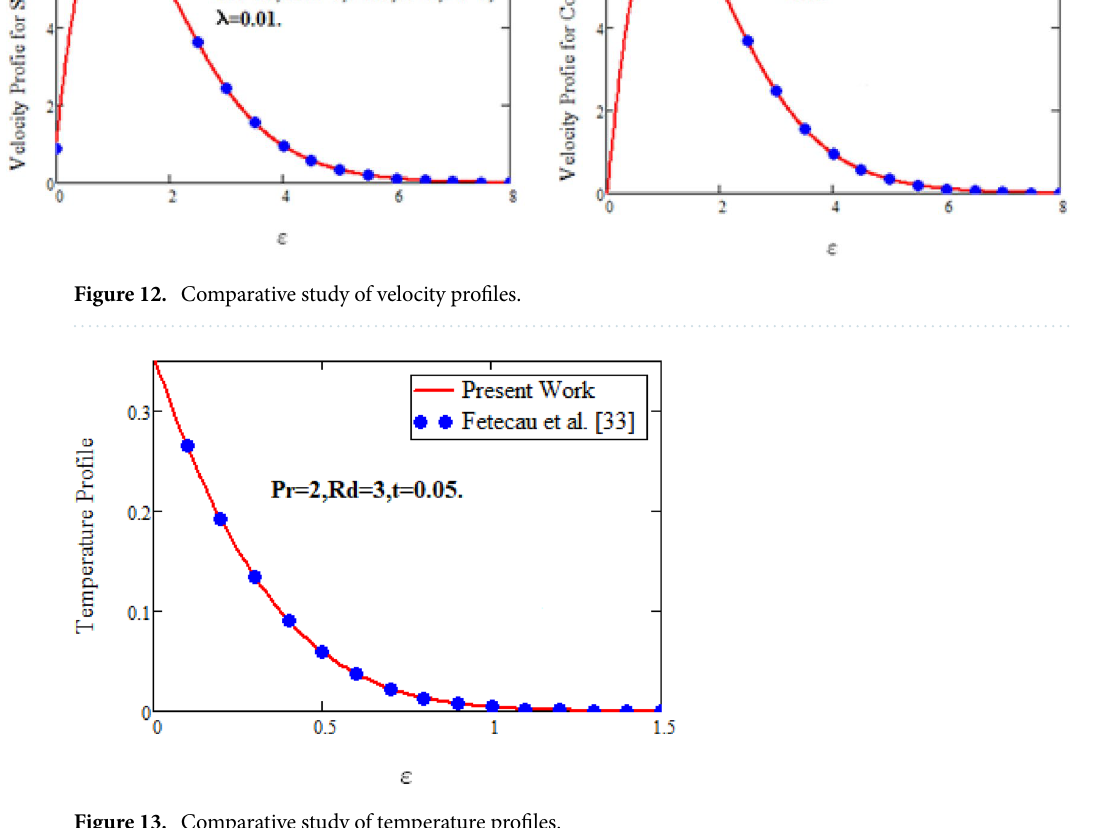
Figure 13. Comparative study of temperature